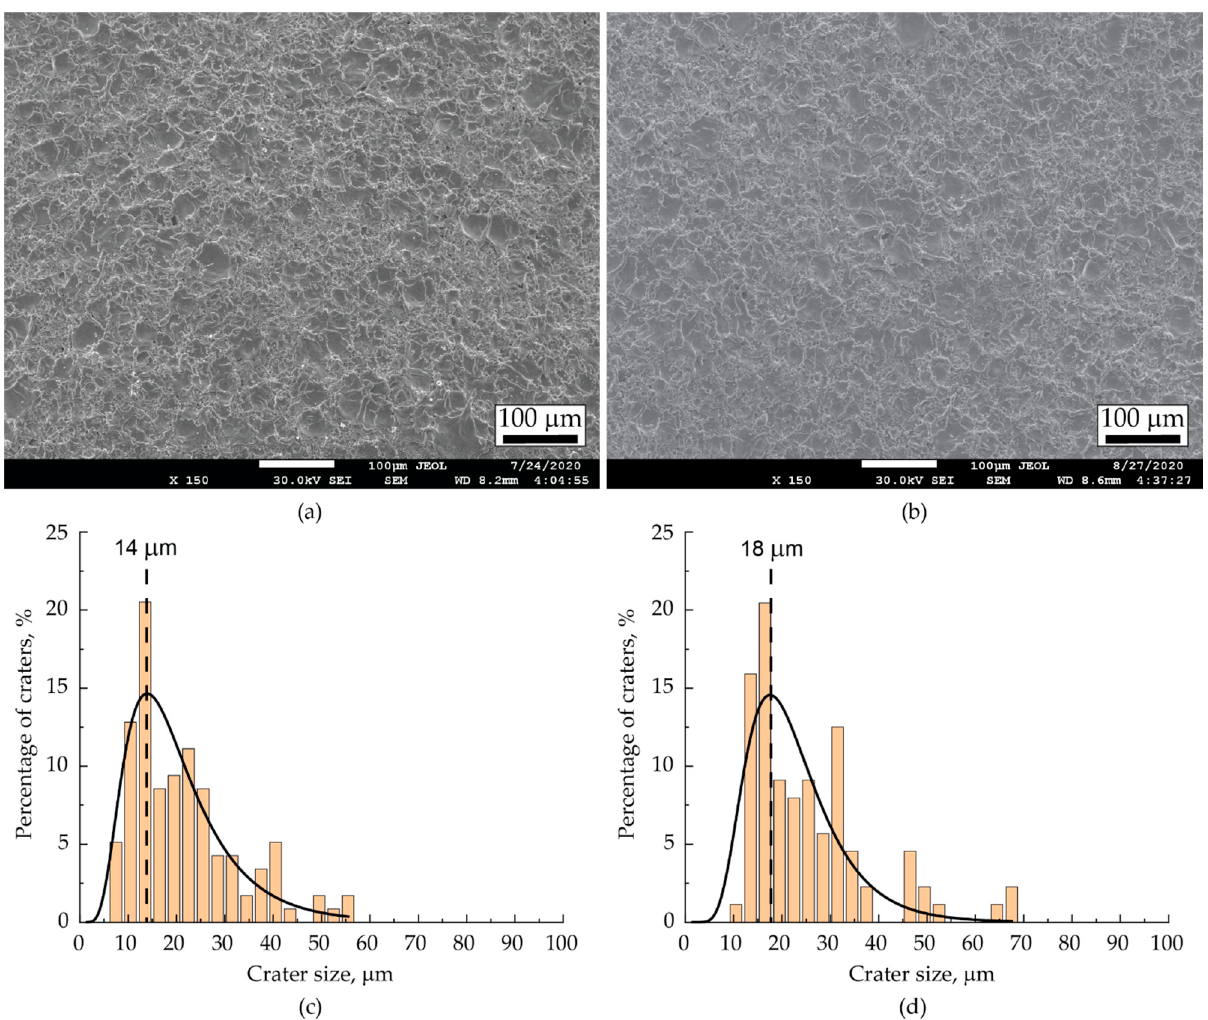
Figure 7. ( a , b ) SEM images of electrode faces subjected to electrical erosion and ( c , d ) the size distributions of craters for the cases of ( a , c ) the initial parallel arrangement of ends and ( b , d ) at the angle of 15°.